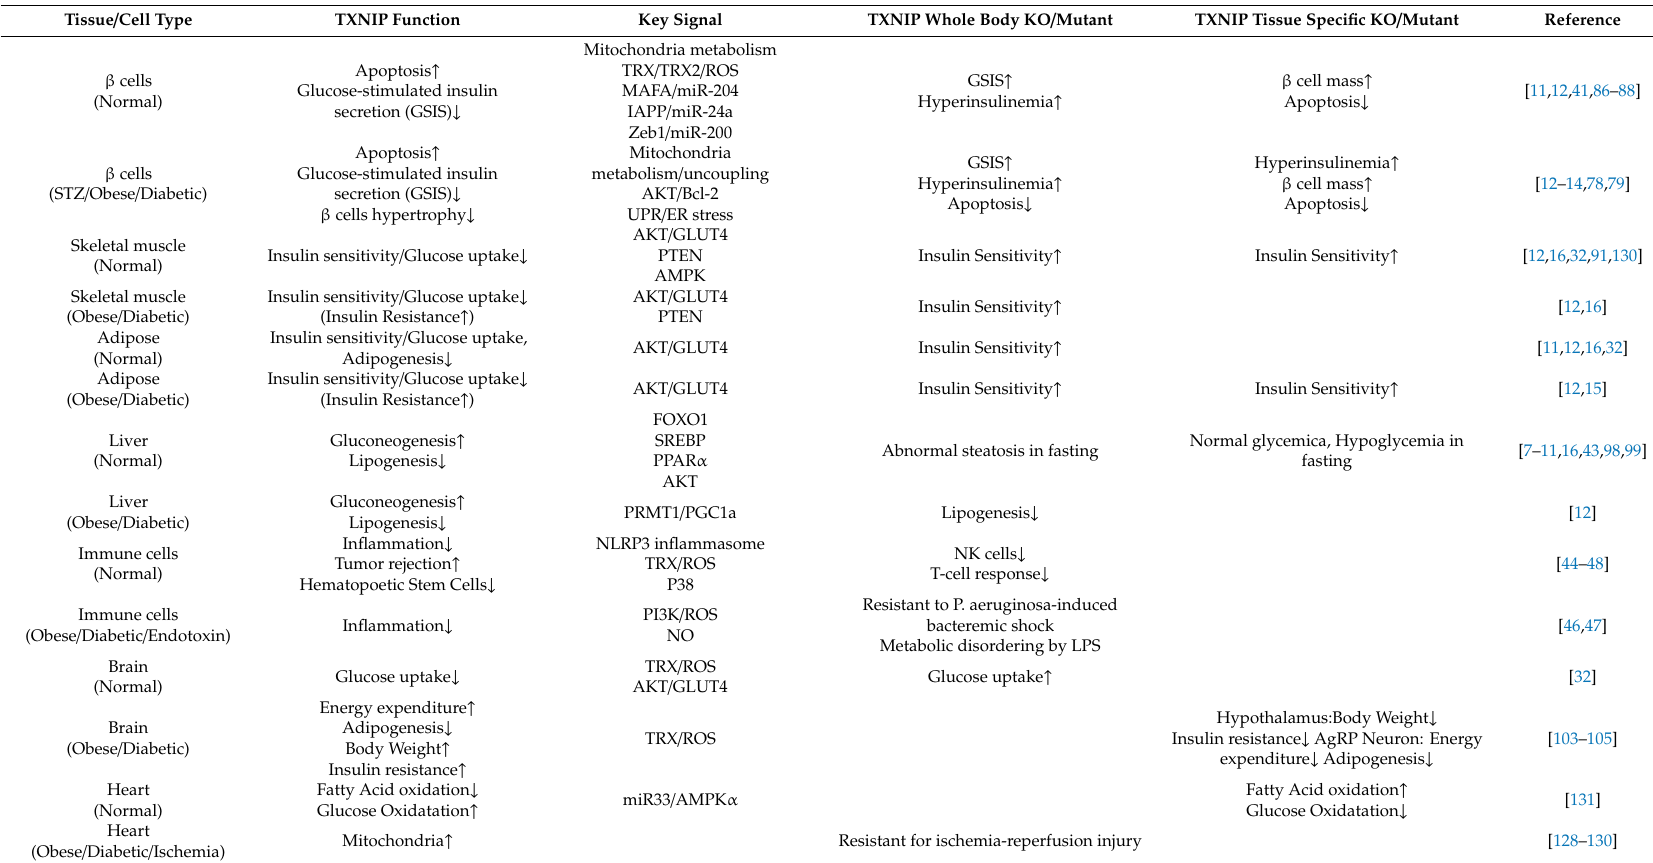
Table 1. Physiological role of TXNIP in normal, obese, STZ, endotoxin, ischemia, and diabetic conditions. The key physiological findings based on genetic knockout (KO) or mutated mice are summarized. ↑ Up-regulation / Enhanced function, ↓ Down-regulation / Reduced